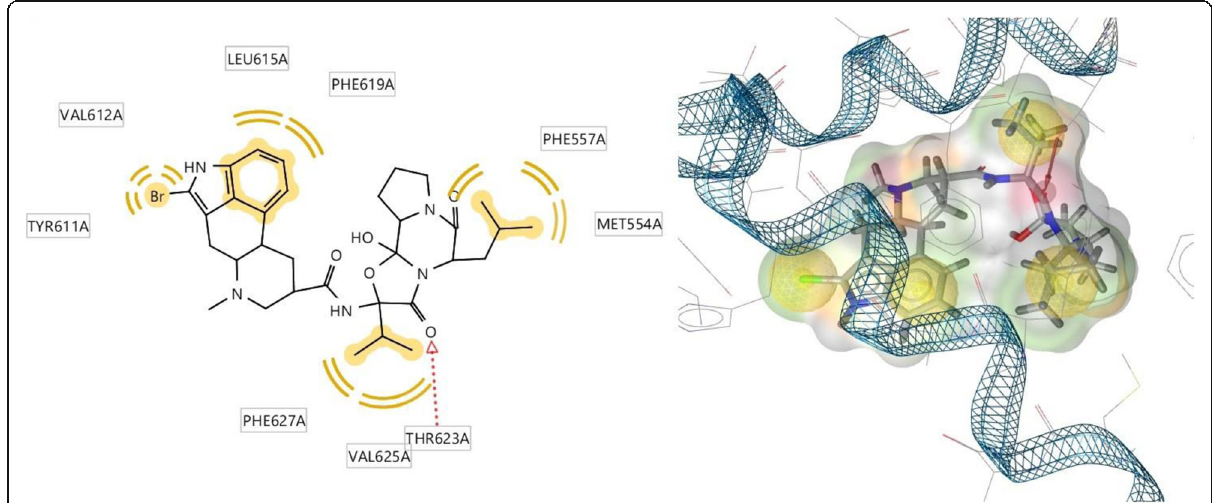
Fig. 2 The binding mode of Bromocriptine within the active site of 5VA1. The hydrogen bond is presented in red dotted line.